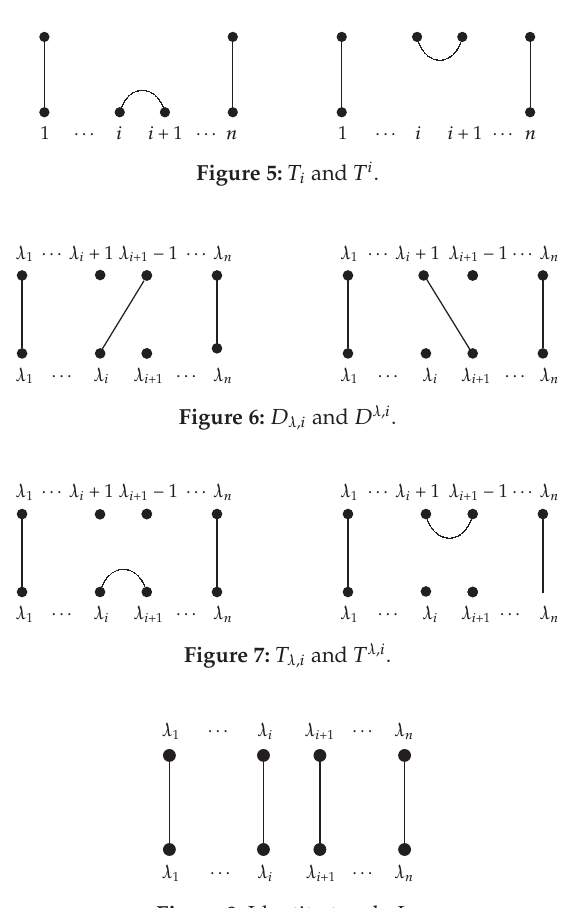
Figure 8: Identity tangle I λ